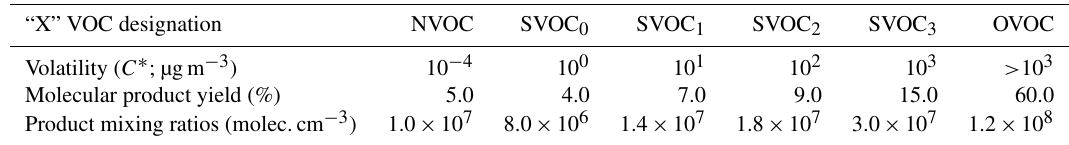
Table 1. Product distribution for VOC ozonolysis used to simulate particle